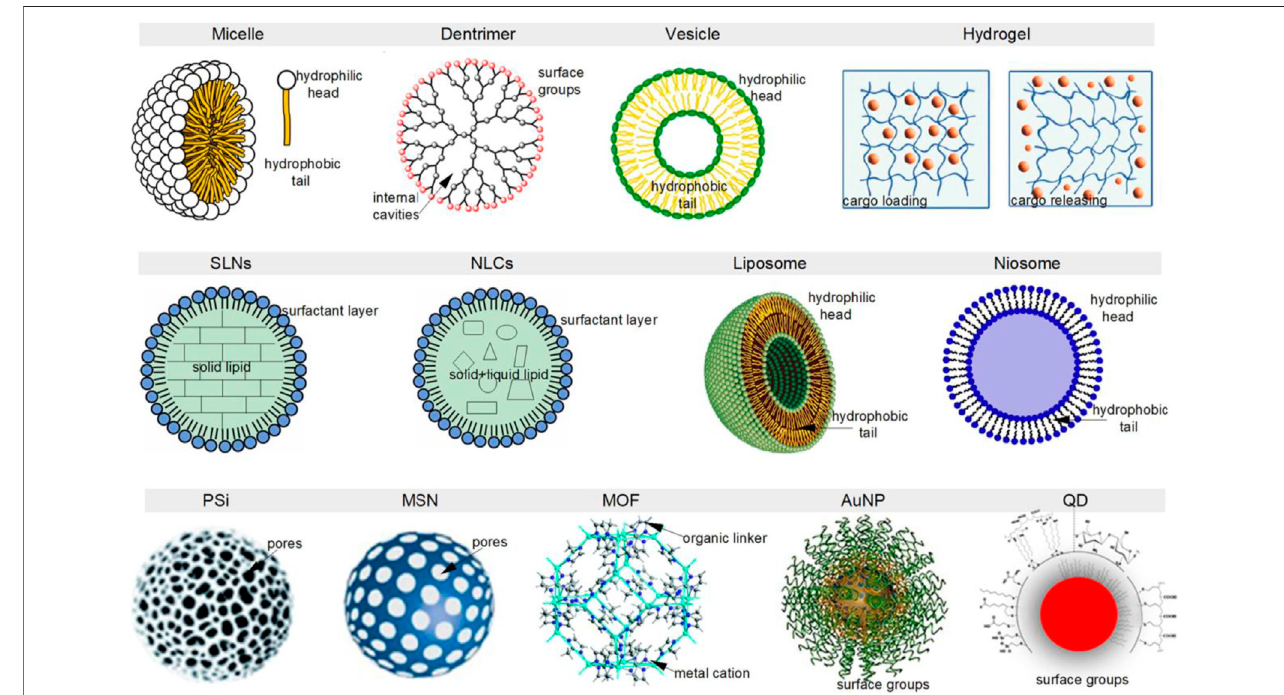
FIGURE 2 | Nanotechnology introduces various types of nanoparticles to be employed in the non-invasive and effective CNS drug delivery which aids in neurogenesis (Figure from article Dubey et al., 2022).